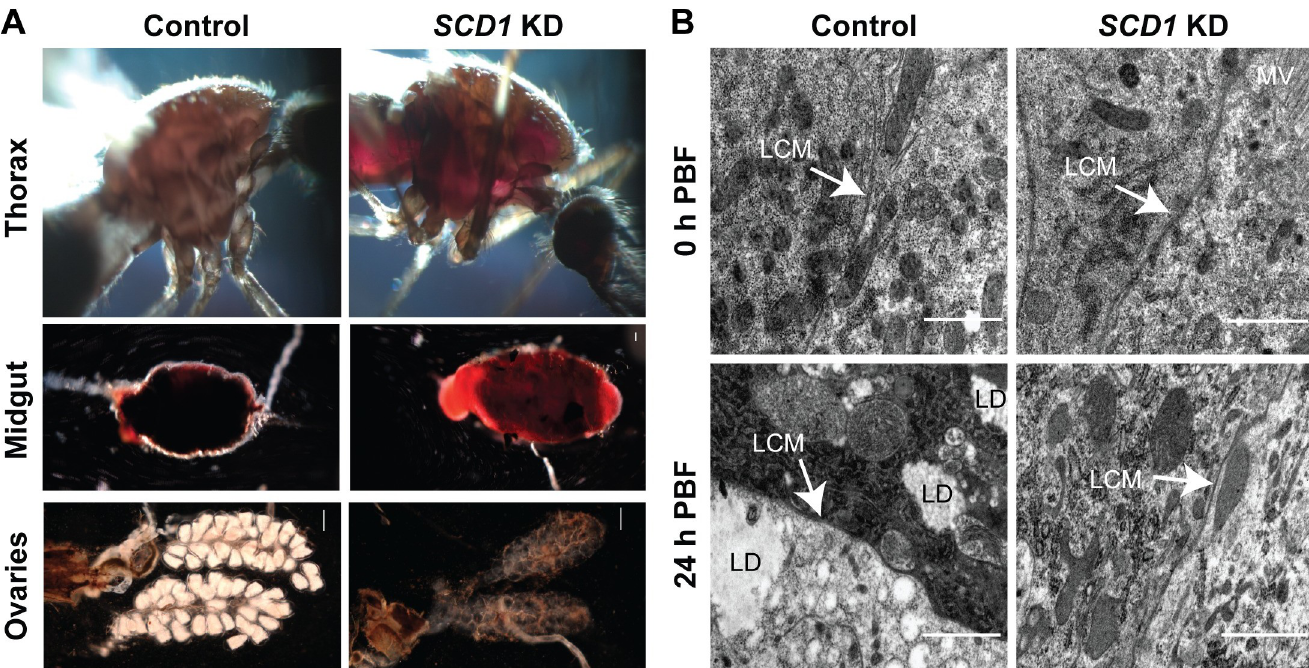
Fig 2. Phenotypic characterization of SCD1 KD mosquitoes. ( A ) Representative pictures of thoraces, midguts and ovaries of blood-fed control (left) and SCD1 KD (right) female mosquitoes at 24h PBM. ( B ) Representative TEM pictures of midgut epithelial cells dissected from control (left) and SCD1 KD (right) female mosquitoes at 0h before blood meal and 24h PBM, respectively. LCM denotes lateral borders between adjacent midgut cells. Thickness of LCM is the mean value of 10 different points on the same LCM. LD denotes lipid droplets and MV denotes microvilli. Scale bar is set at 1 μ m.